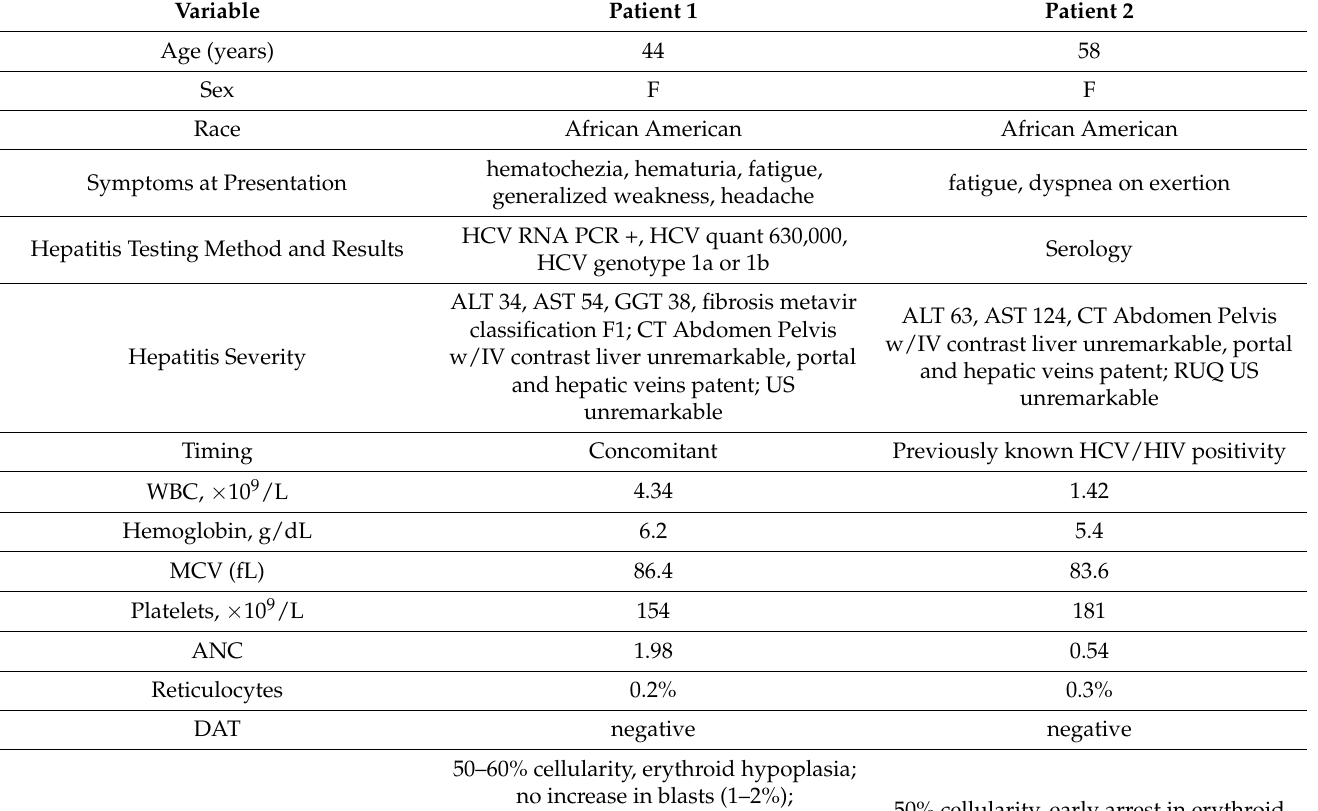
Table 1. Clinical Characteristics at onset and follow-up of patients with hepatitis C and pure red cell